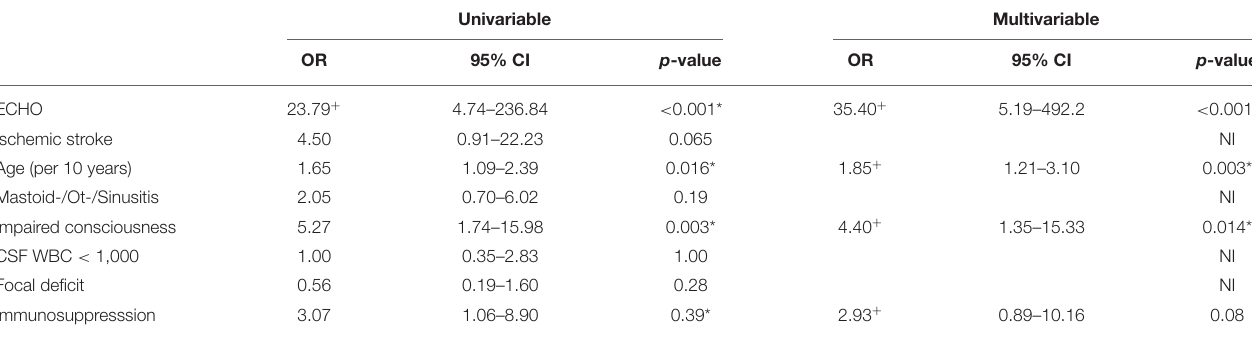
TABLE 3 | Logistic regression analysis of predictors for poor clinical outcome (mRS 5–6) among patients with culture-proven community-acquired bacterial meningitis ( n =